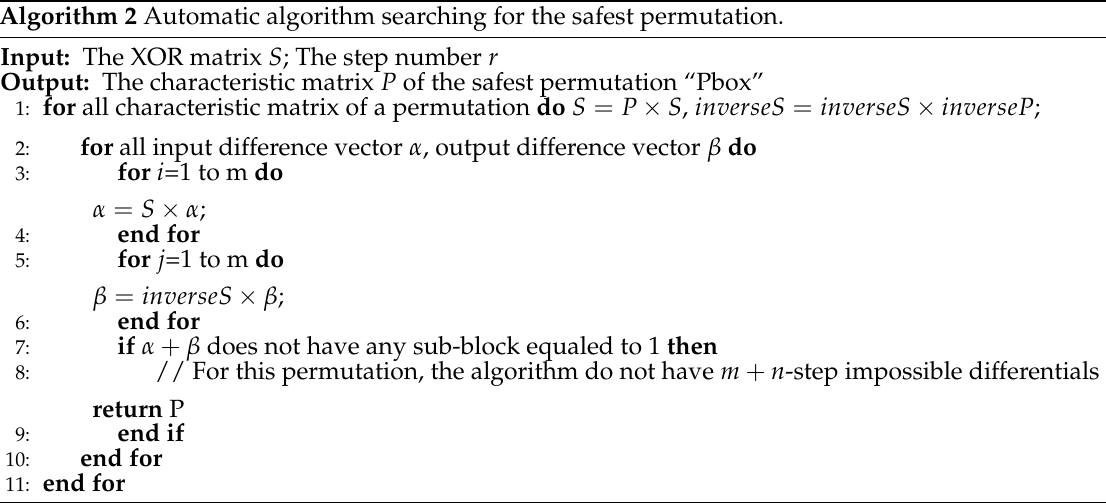
Algorithm 2 Automatic algorithm searching for the safest